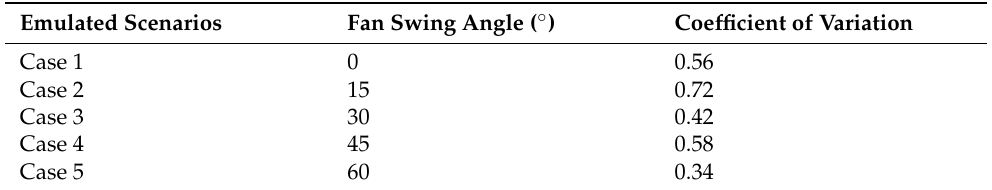
Table 3. Summary of the coefficients of variation of horizontal velocity profiles for different fan swing angles.